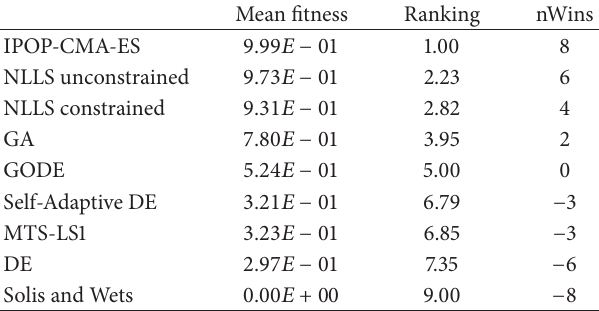
Table 14: Mean fitness, average ranking, and number of wins (nWins) in pair-wise comparisons with the other algorithms on the 2-term exponential function.